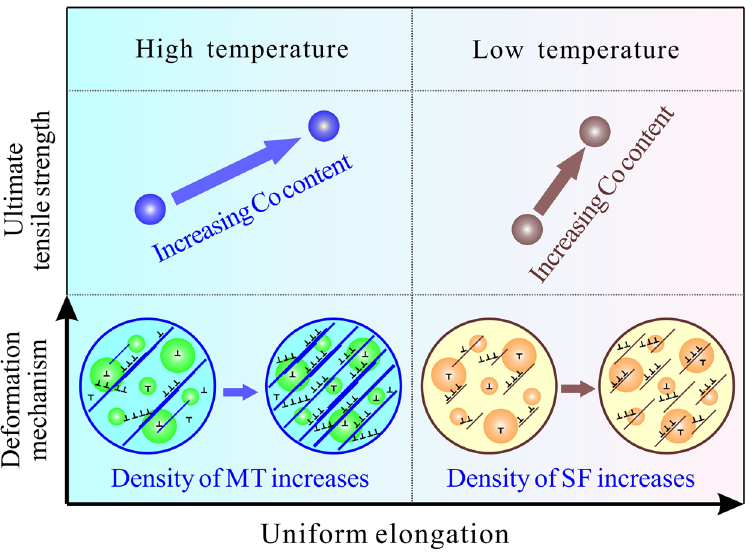
Figure 6. Schematic diagram for describing the relation of microscopic deformation mechanisms and macroscopic mechanical